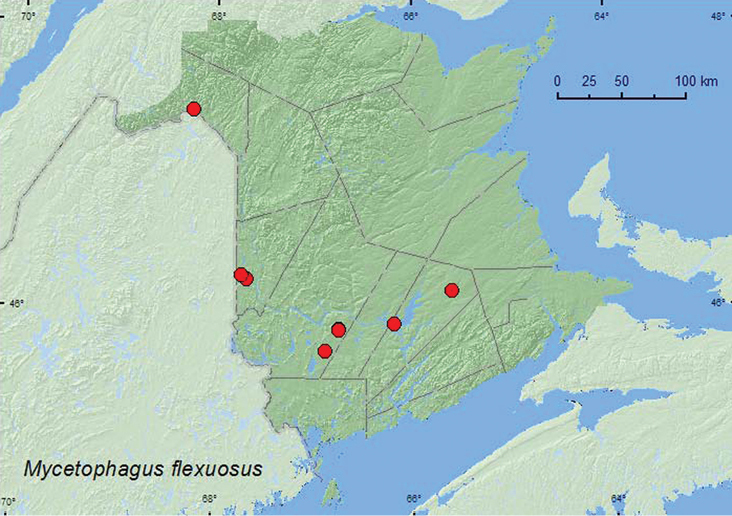
Collection localities in New Brunswick, Canada of Mycetophagus flexuosus.